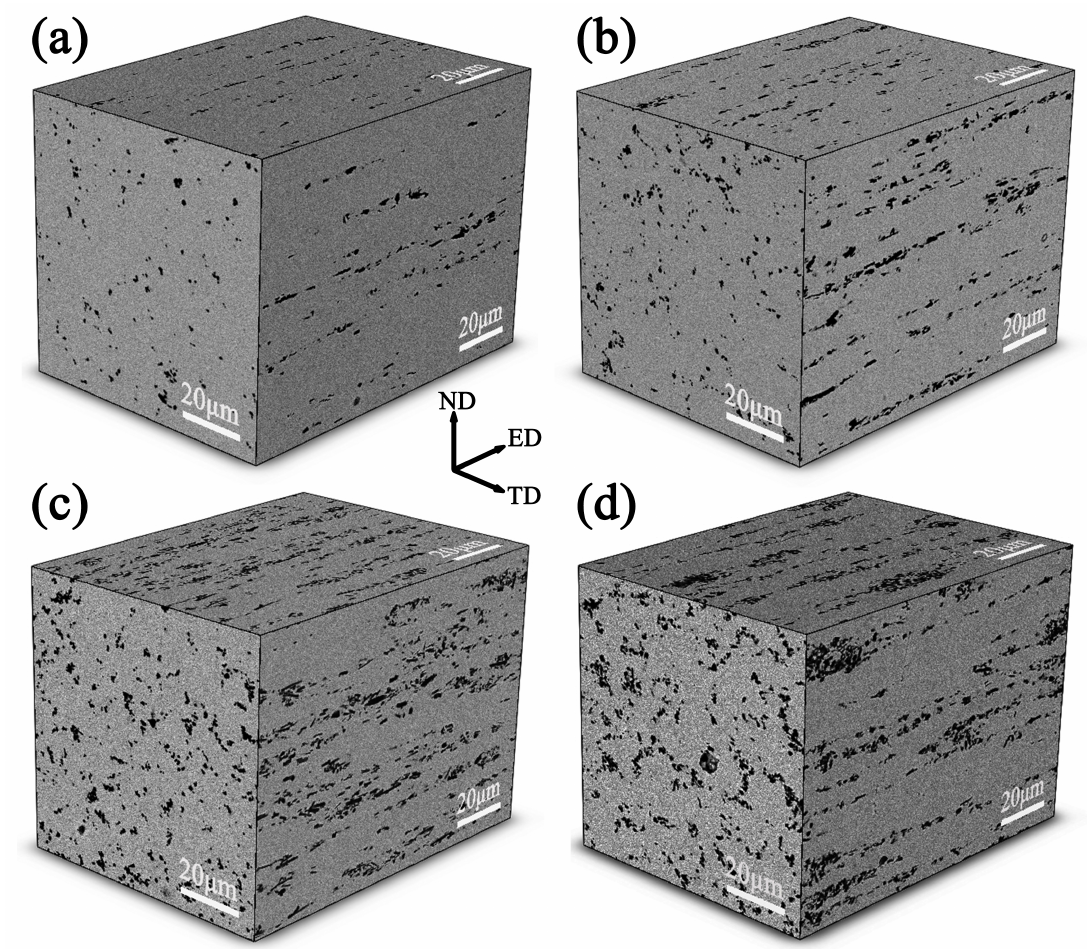
Figure 3: SEM morphology of the extruded SiC w /Cu composite with different volume fraction: (a) 1 vol.%, (b) 3 vol.%, (c) 5 vol.%, (c) 7 vol.%. ED, ND, TD is extruding direction, normal direction, and transverse direction,